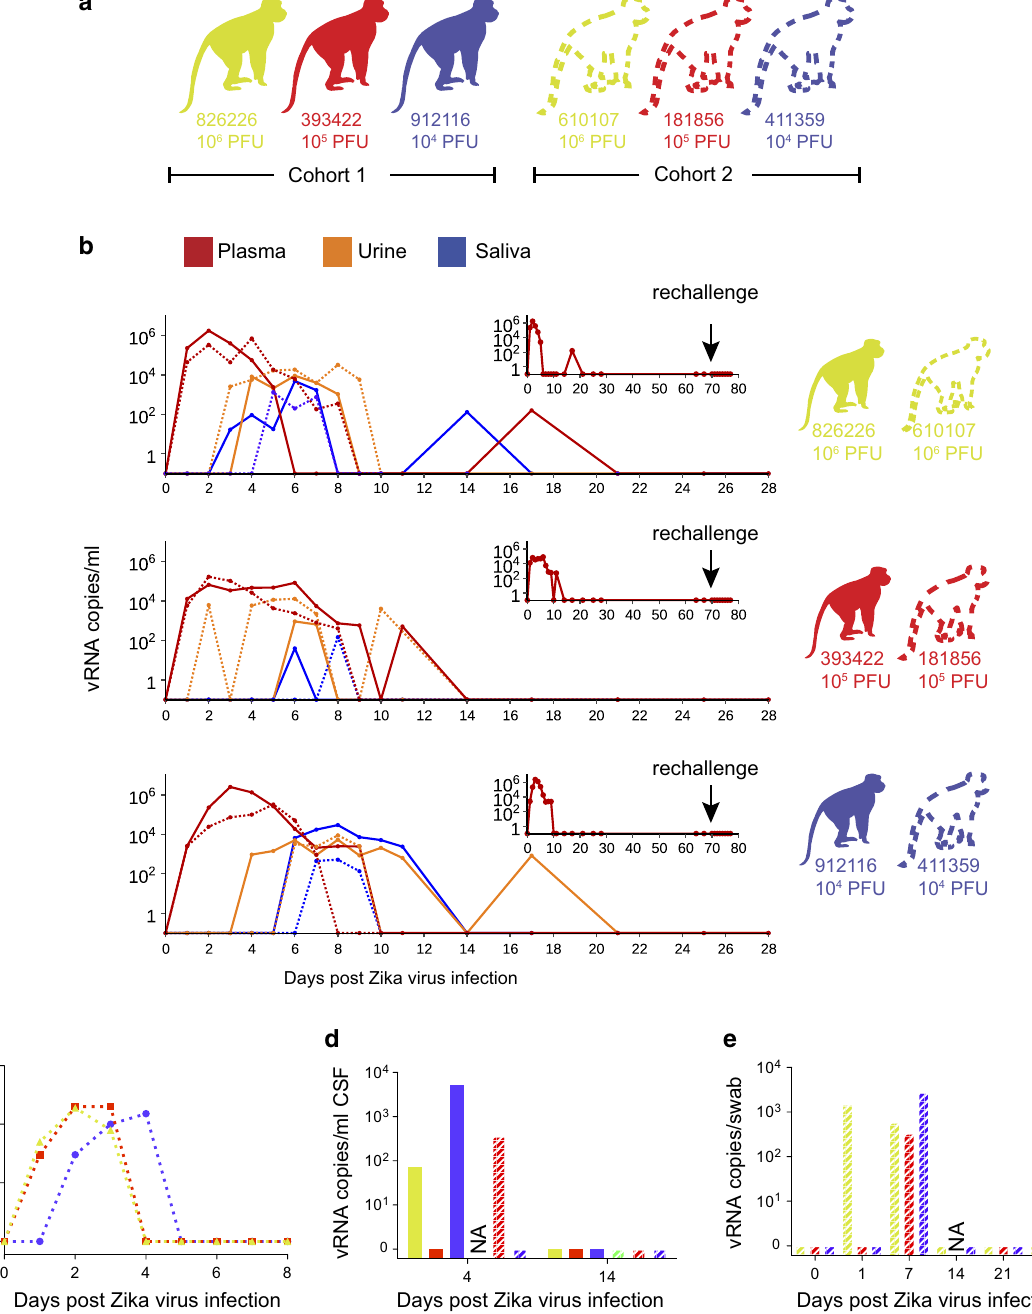
Figure 2 | Animal cohort definitions and ZIKV viral load from rhesus macaque fluids. ( a ) Animals included in this study and the ZIKV doses used to infect them. Solid lines and bars throughout the figure represent cohort 1 animals by colour, while stripped bars and dotted lines represent cohort 2 animals by colour. ( b ) Viral RNA loads measured in plasma, urine and saliva for the two animals challenged with each dose of virus through 28d.p.i. Cohort 1 animals are represented by a solid line, while cohort 2 animals are represented by a dotted line for each fluid. Inset: vRNA loads from cohort 1 animals measured before and after rechallenge with homotypic Zika virus as indicated by an arrow. ( c ) Number of plaque-forming units per ml of serum for cohort 2 animals. ( d ) Viral RNA load per ml of CSF collected on 4 and 14d.p.i. ( e ) Viral RNA load per vaginal swab collected on 0, 7, 14, 21 and 28d.p.i. NA, sample not